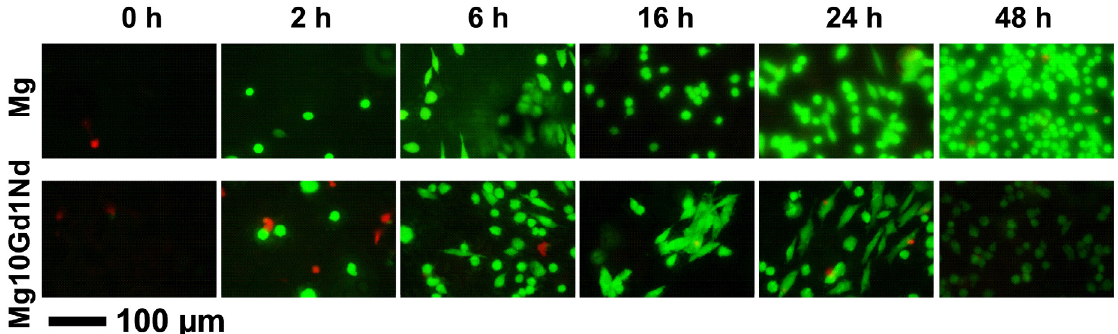
Figure 2. Life Dead Staining of Saos-2 cells incubated on two materials with varying pre-incubation